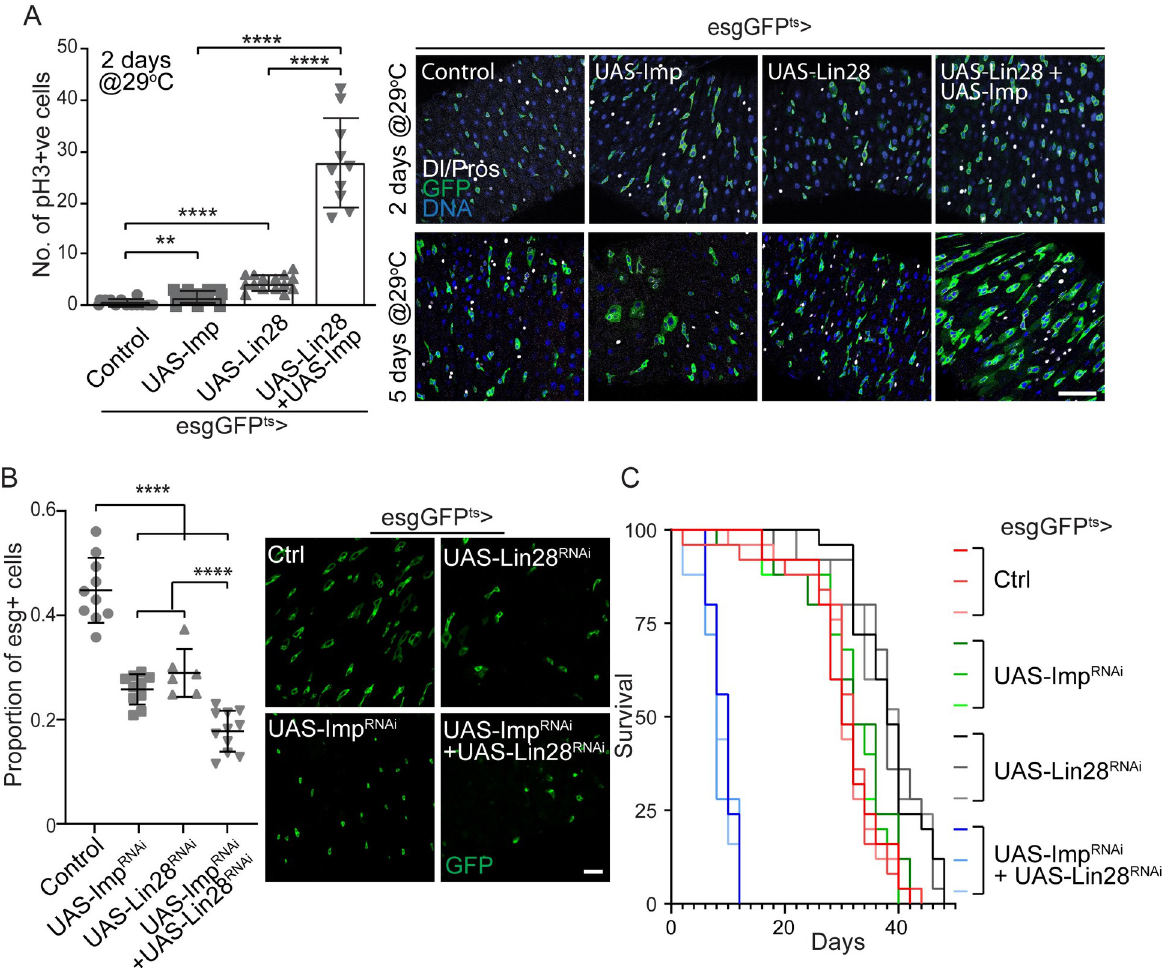
Fig 3. Imp and Lin28 cooperate to regulate ISC proliferation. (A) Co-expression of Lin28 and IMP leads to synergistically increased ISC proliferation. Box plot representing the quantification of the number of pH3 positive cells per gut that shows that ISCs/EBs specific co-expression of Imp and Lin28 leads to high number of mitotic cells 2 days after transgene induction. Representative images are shown to illustrate the expansion of esg-positive cells 5 days post induction of both transgenes. GFP is expressed in ISCs and EBs, Delta stains for ISCs and Prospero (Pros) stains for EEs. DNA is stained by Hoechst. Student’s t-test ���� p-value = < 0.0001; �� p = 0.0036. (B) Double knockdown of Imp and Lin28 results in a long-term loss of progenitors in adult guts, 7 days after transgene activation. Plot presenting the comparison of the percentage of esg- positive in the posterior midgut (measured by the ratio of GFP positive cells vs the total number of cells, counted by DNA-positive nuclei) showing a reduced number of progenitors when either Imp or lin28 are knocked down, which is exacerbated when both Imp and Lin28 are knocked down. Representative confocal images are shown to illustrate the changes in the number of GFP-positive cells. (C) Combined loss of Imp and Lin28 reduces adult female lifespan. Adult specific knockdown of Imp and Lin28 in esg-positive cells leads to accelerated death when flies are reared at 29˚C. Kaplan-Meier survival curves of three populations of 25 flies are shown for each genetic condition. In A and B, scale bar: 10 μ m.